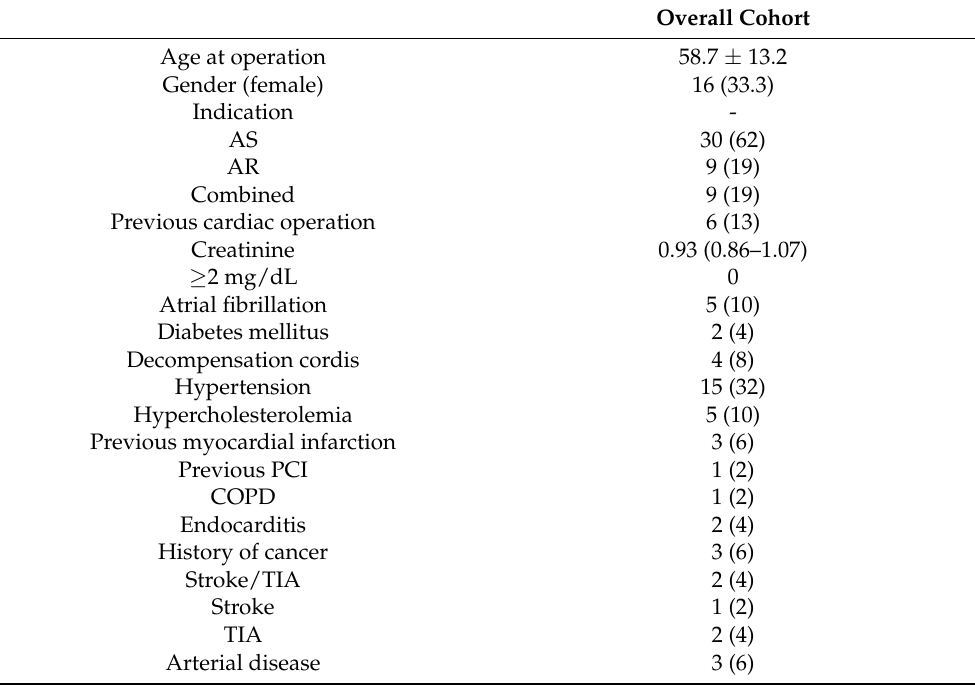
Figure 2. Long-term relative survival after SAVR with aortic surgery compared to the Dutch population. Relative survival compared to the age-, gender-, and year-matched population in the overall cohort. The shaded area represents the 95% confidence interval. Table 1. Baseline and procedural characteristics in the overall cohort.